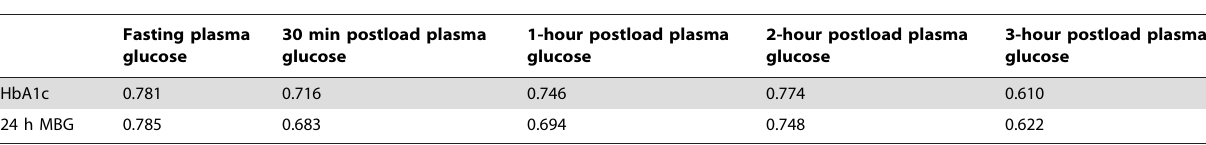
Table 2. Spearman correlation coefficients among HbA1c and glucose, 24 h MBG and glucose ( n =673).